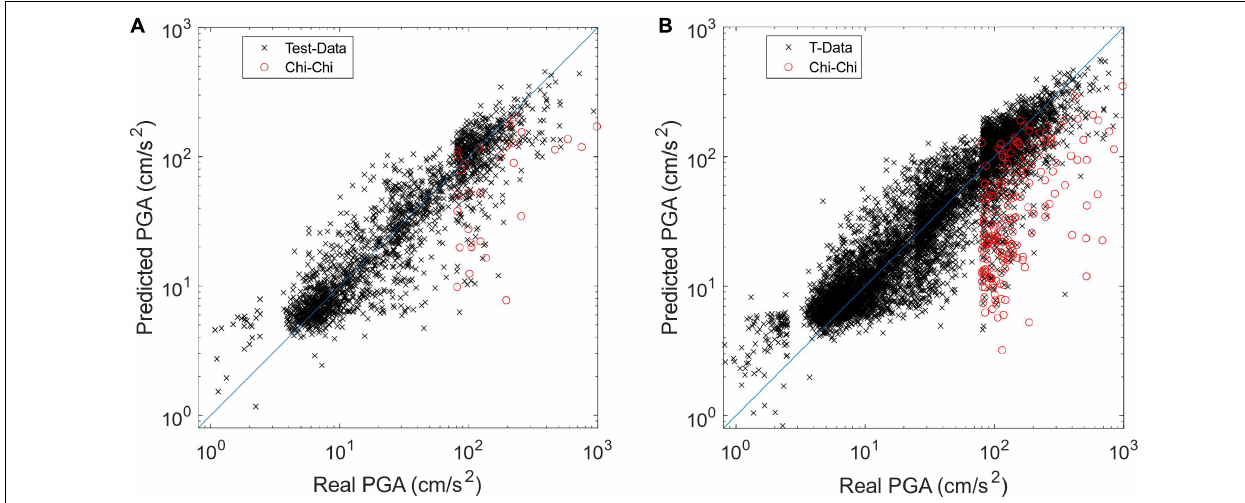
FIGURE 7 | The predicted PGA distribution of (A) the 2,000 test data and (B) all the 10,000 T-data.